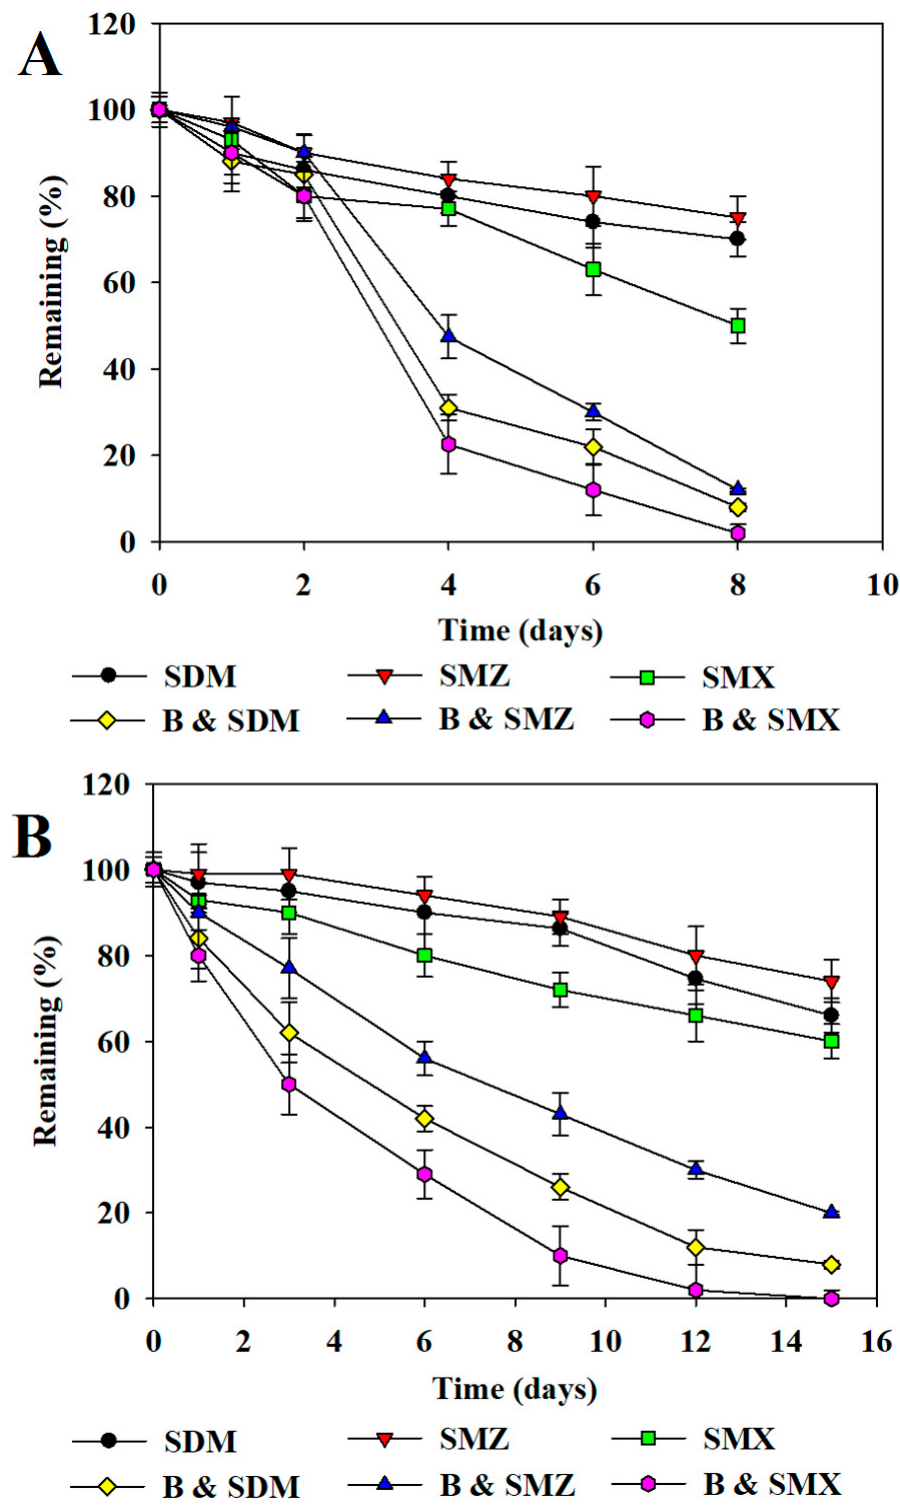
Figure 4. Degradation of sulfonamides with and without degrading bacteria in sludge. Aerobic ( A ) and anaerobic ( B ) degradation of SAs. SMZ: sulfamethazine, SMX: sulfamethoxazole, SDM: sulfadimethoxine. B: isolated antibiotic-degrading bacteria. Data from three independent experiments are presented as the means ± SE.